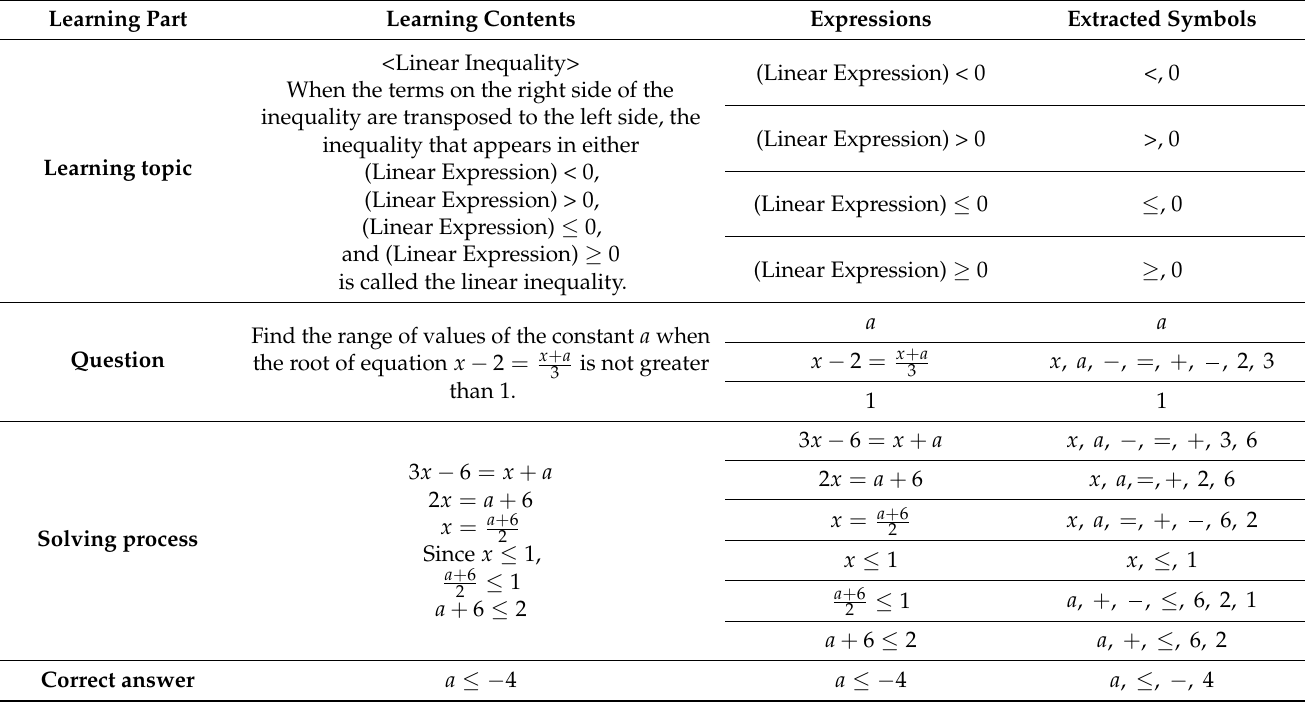
Table 2. Sample symbols extracted from learning